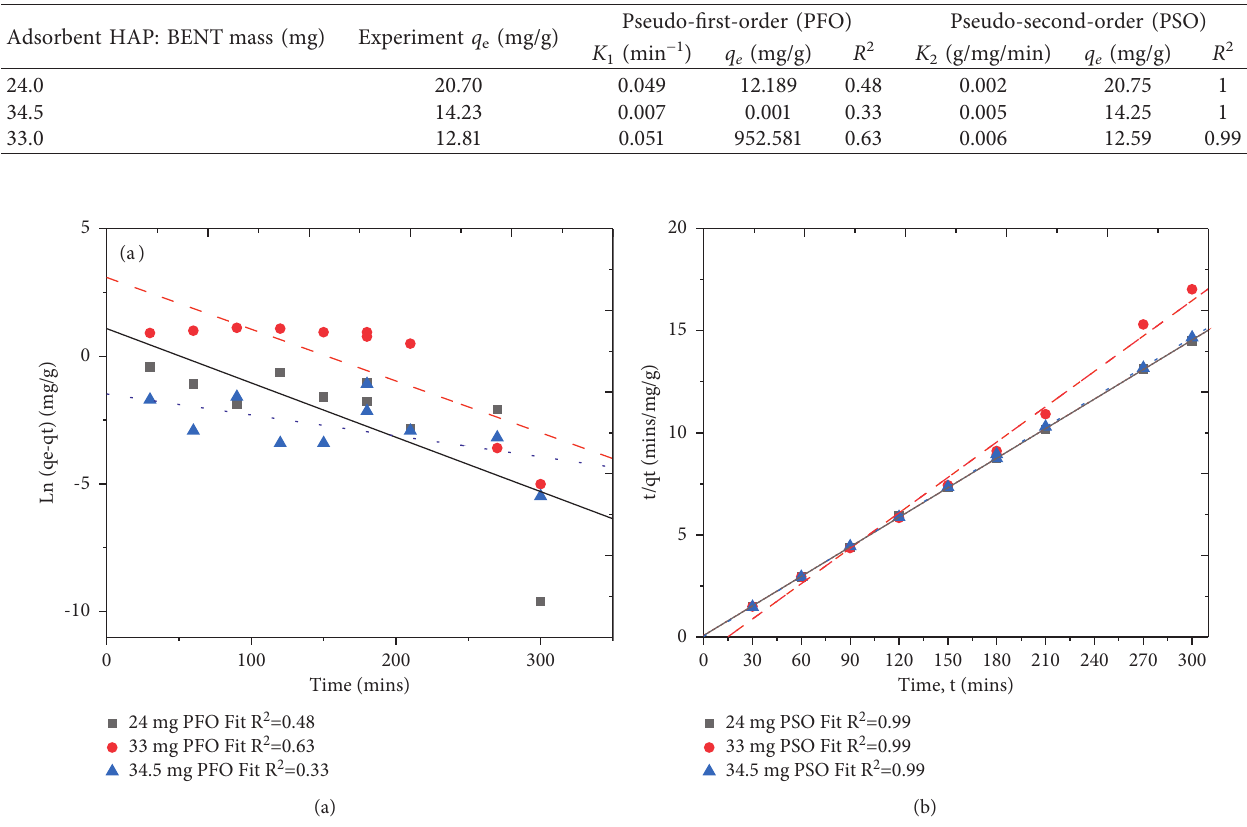
Figure 9: Kinetic modeling. (a) PFO model fit. (b) PSO modeling fit for HAP:BENT adsorbent combined masses of 24mg, 33mg, and